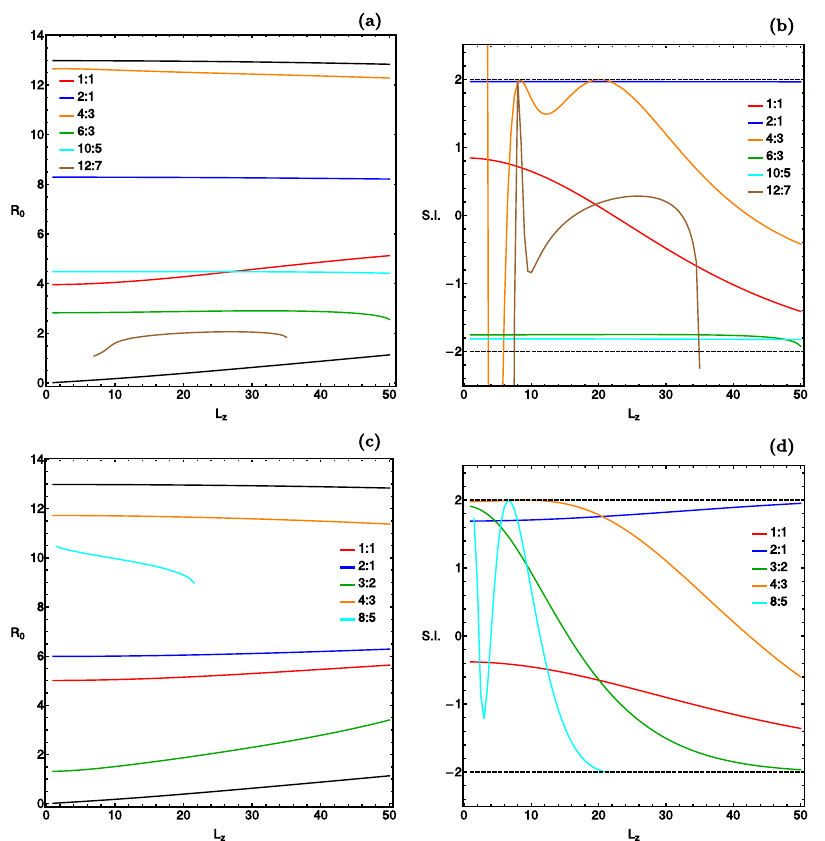
Fig. 9. Evolution of the R coordinate of periodic orbits as a function of the angular momentum L z for the PH models (panel a) and OH models (panel c), and the evolution of the stability index S.I. as function of L z for the PH models (panel b) and OH models (panel